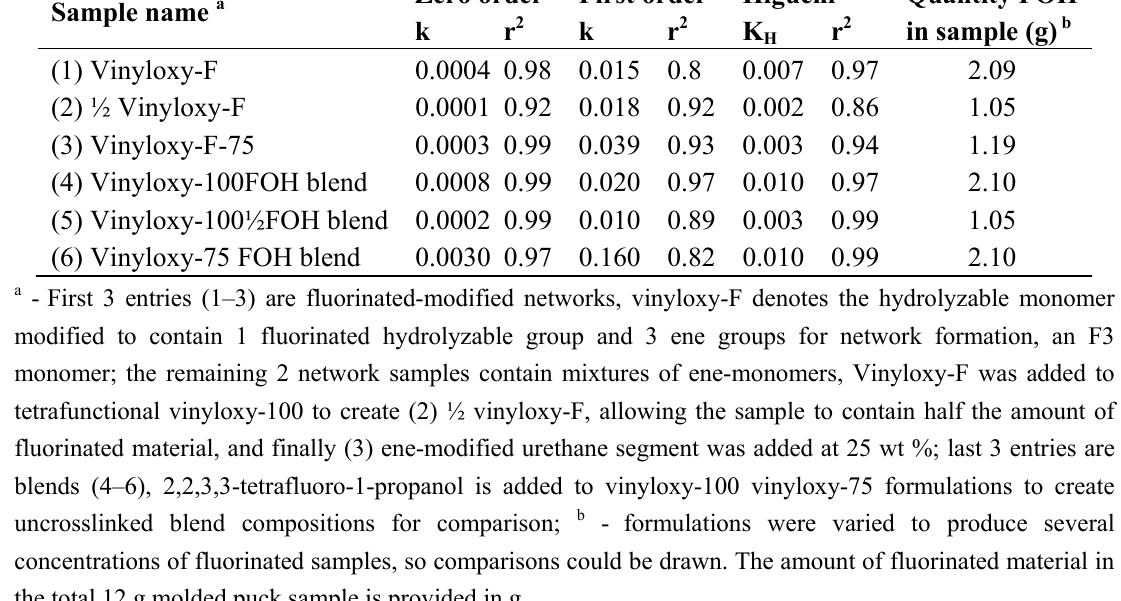
Figure 6. Change in concentration of 2,2,3,3-tetrafluoro-1-propanol with time for vinyloxy-100 FOH blend, obtained from 19 F analysis of samples in D